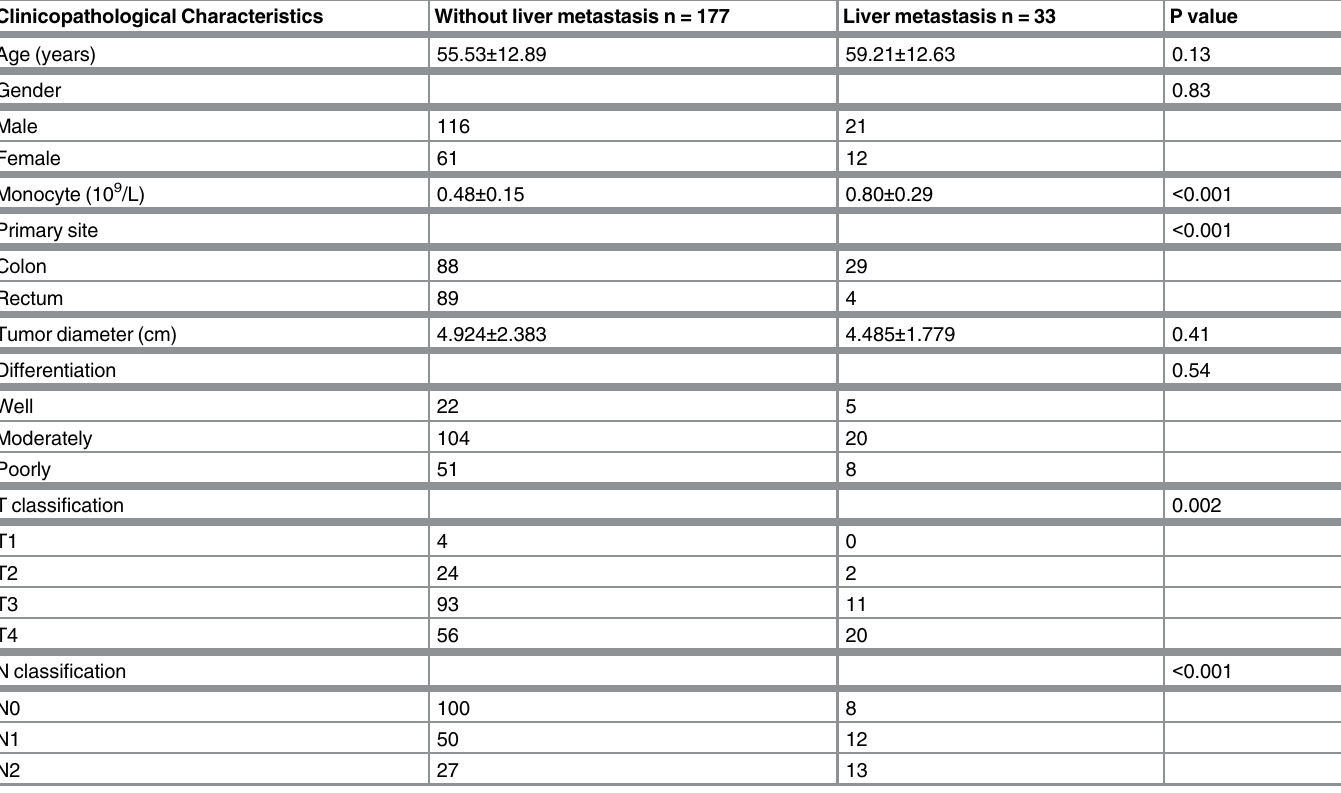
Table 1. Relationship between colorectal cancer liver metastases and clinicopathological characteristics. Clinicopathological